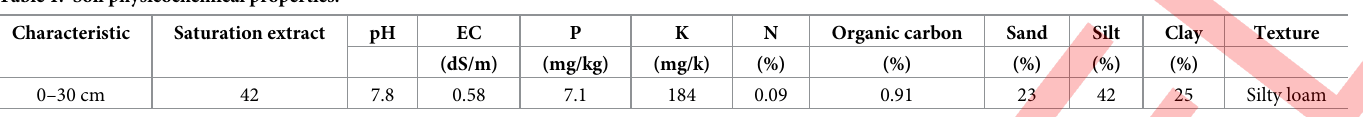
Table 1. Soil physicochemical properties.